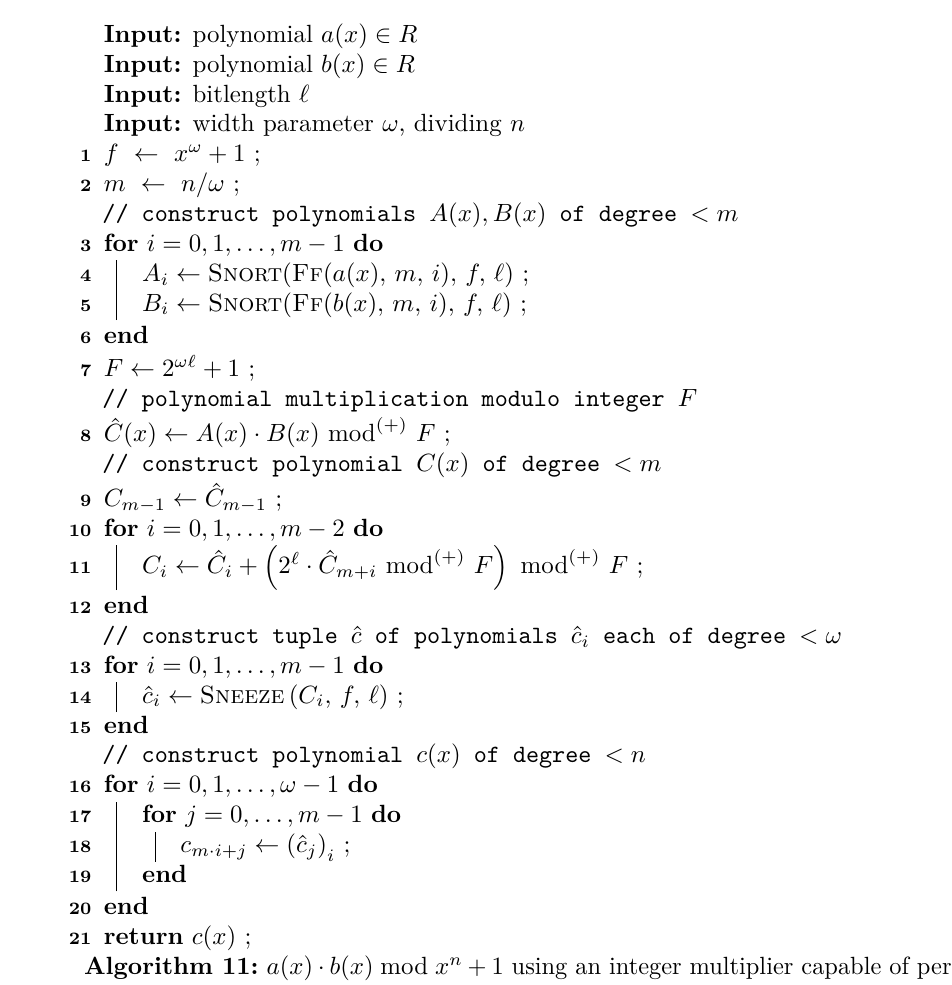
Implementing RLWE-based Schemes Using an RSA Co-Processor